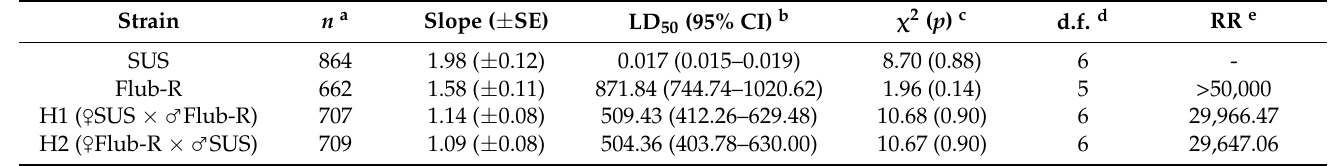
Table 2. Dose–mortality of flubendiamide to susceptible (SUS) and resistant (Flub-R) strains of H. armigera and heterozygotes from reciprocal